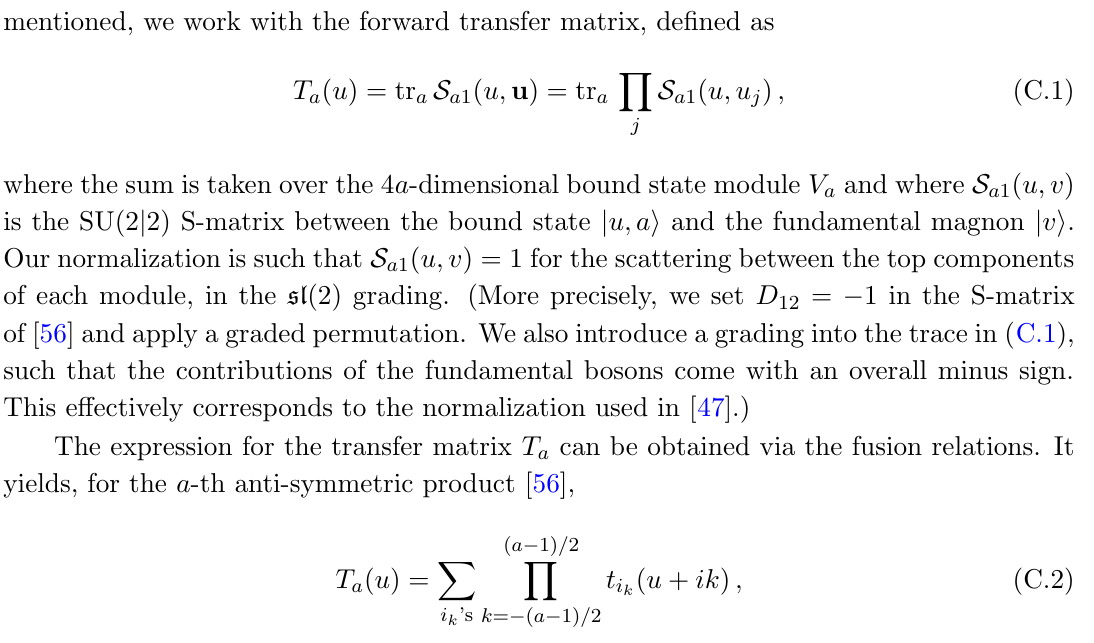
Figure 14 . There is one type of root for each node of the psu (2 j 2) Dynkin diagram. The momentum carrying root u corresponds to the top component in the multiplet, which in our case is a fermion 1 . The fermionic root y is associated to a SUSY generator that changes the fermion 1 into a boson (cid:30) 1 . The su (2) b root w (cid:13)ips the spin of the bosonic component: (cid:30) 1 ! (cid:30) 2 . Finally, the fermionic root ~ y maps back to a fermion: (cid:30) 2 ! 2 , which is the bottom component of the su (2) f multiplet the two fermions belong to, as well as the bottom component of the fundamental